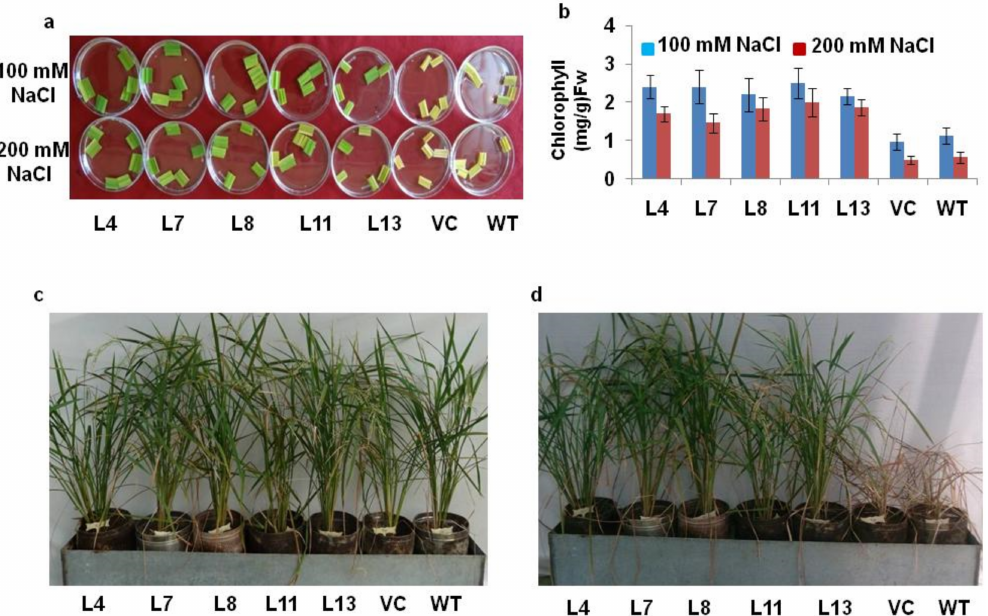
Figure 2. Salinity tolerance of PDH45 -overexpressing transgenic T 1 IR64 rice lines. ( a ) Leaf disk senescence assay under 100 and 200 mM NaCl treatment. ( b ) Chlorophyll content (mg/g fw) in PDH45 transgenic lines after salt treatment. ( c ) Third day in 200 mM NaCl treatment. ( d ) After 15 days of NaCl